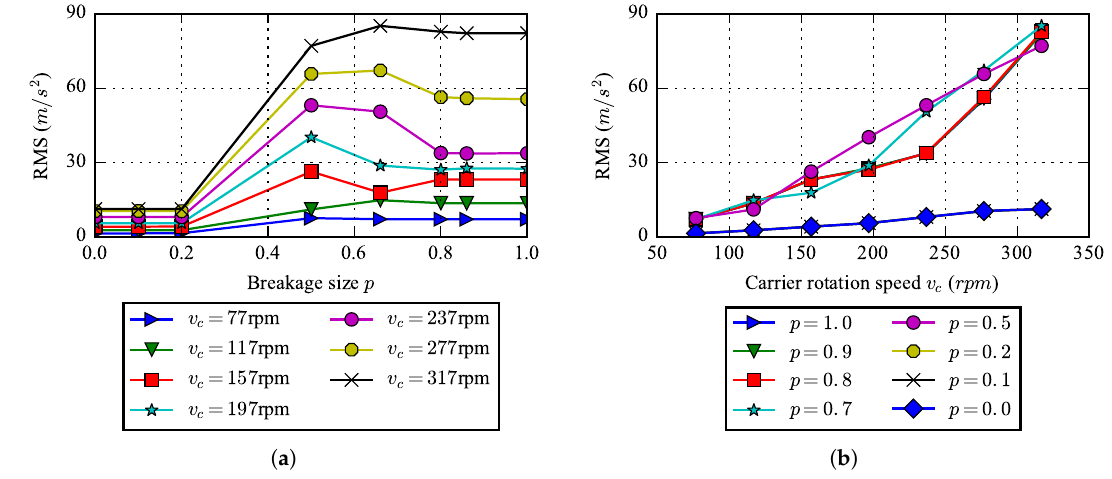
Figure 6. The changes of root mean square (RMS) of the simulated ring vertical acceleration versus the ( a ) breakage size and ( b ) rotational speed.